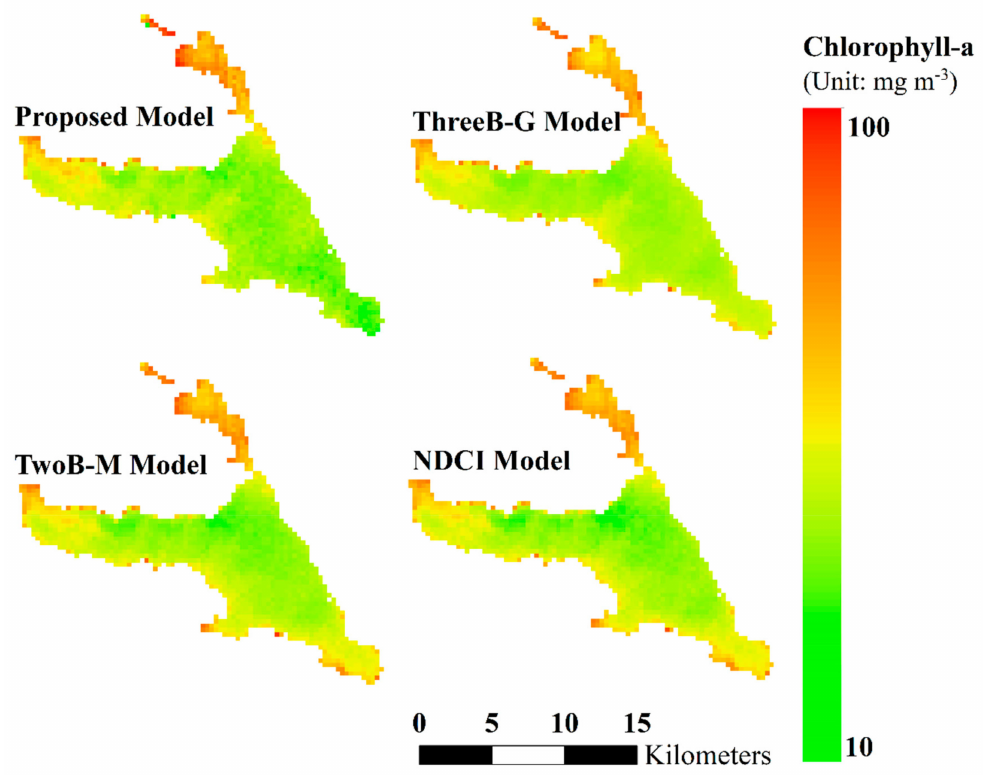
Figure 5. Maps of spatial distribution of Chl-a in 2010 generated by our proposed model (OptiM-3), ThreeB-G [13], TwoB-M [18], and NDCI [25] (unit: mg · m − 3